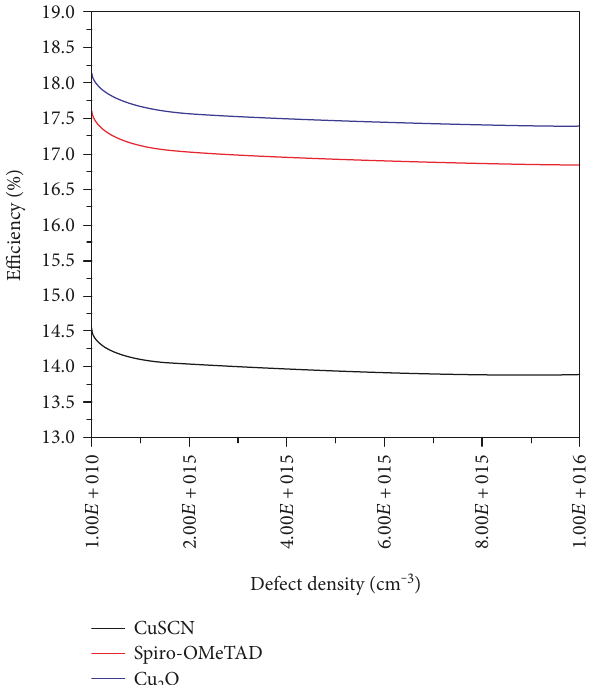
Figure 6: Defect density of the CH e ffi ciency.